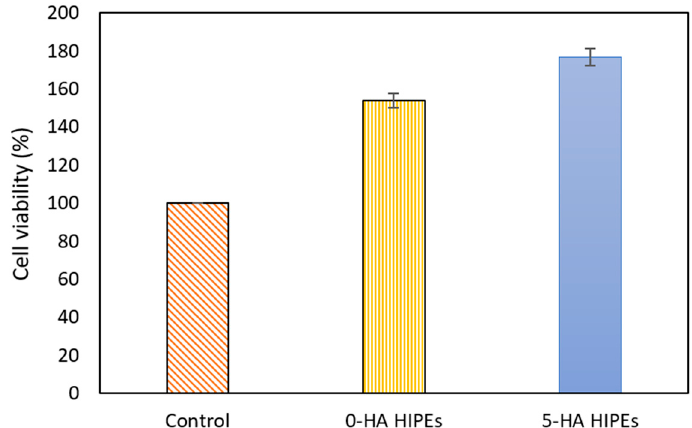
Figure 10. Cell viability assay (MMT) of mouse fibroblast cells (L-929) with different amount of HA on poly(TT/DPEHA)HIPEs for 24 h.